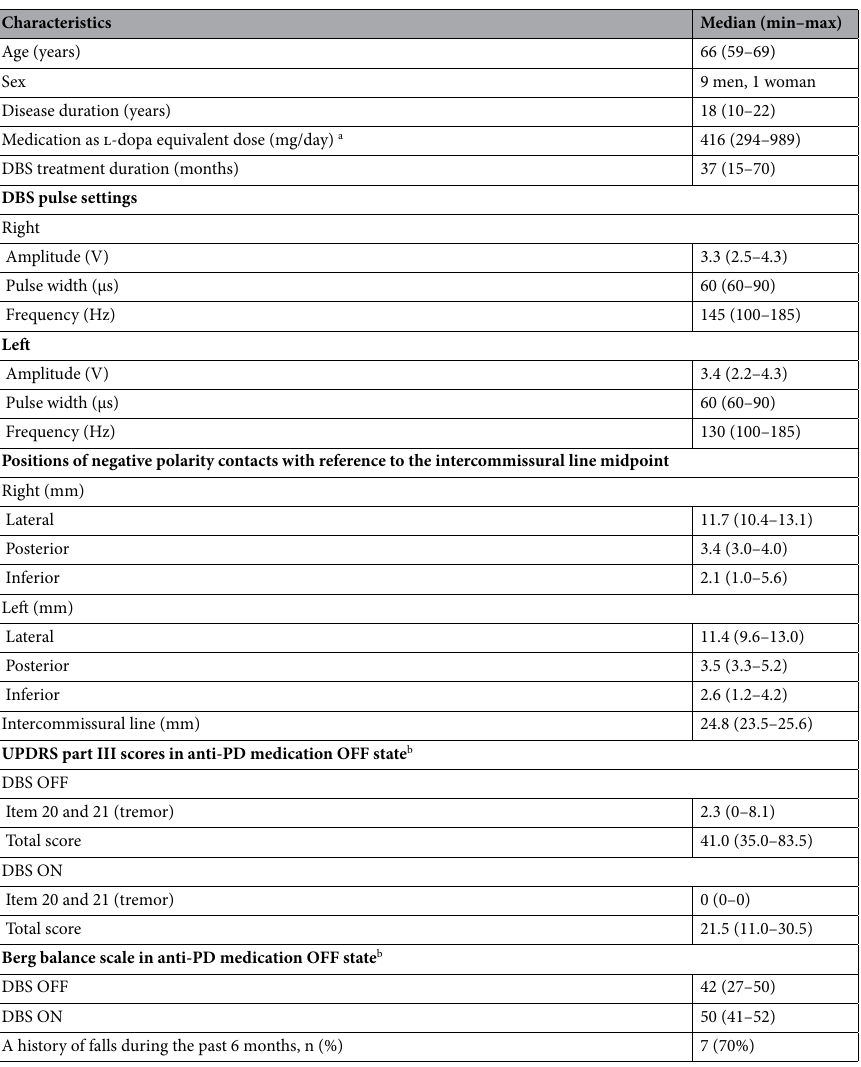
Table 5. Characteristics of patients with Parkinson’s disease (PD). a Calculated equivalent doses of Levodopa according to the method presented by Østergaard et al. 49 , and Calne 50 . All participants received L-dopa in their daily life, and 7/10 subjects received also dopamine agonists. b UPDRS part III: Unified Parkinson’s disease Rating Scale, motor examination. The maximum total score is 108 points (higher scores = more severe motor symptoms). The Berg Balance scale has a scoring range from 0–56 points (higher scores = better). The evaluations were performed in anti-PD medication OFF state. All anti-Parkinsonian medications were withdrawn overnight for 10–12 h. The UPDRS assessments and balance assessments were done at the same occasion as the assessments of